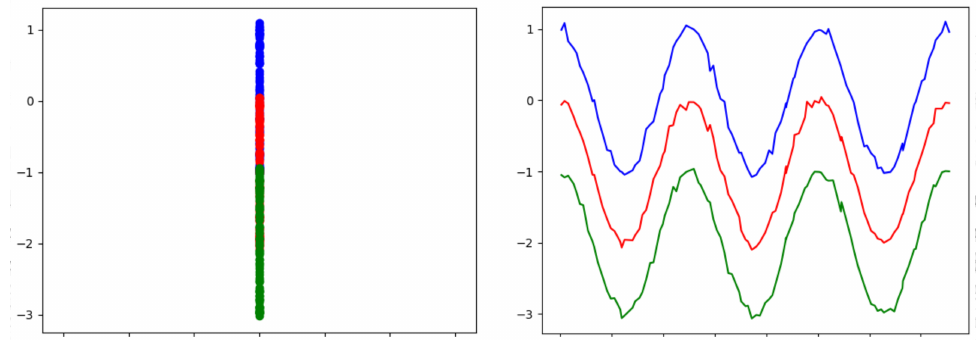
Figure 3. ( Left ): A scatter of points collapsed to have no temporal component. The three colors indicate three different clusters, but it is not possible to identify overlap. ( Right ): The scatter has been expanded by its original temporal